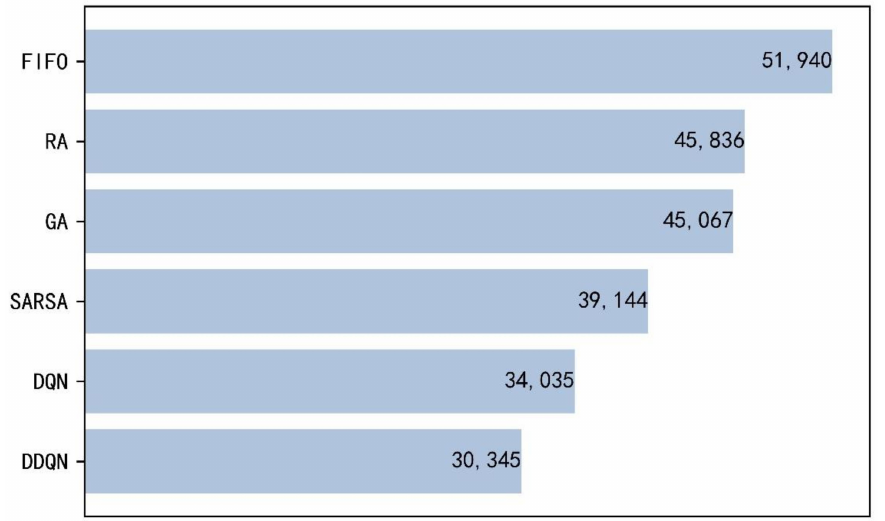
Figure 5. Average total earliness and tardiness penalties of the algorithms compared for all test